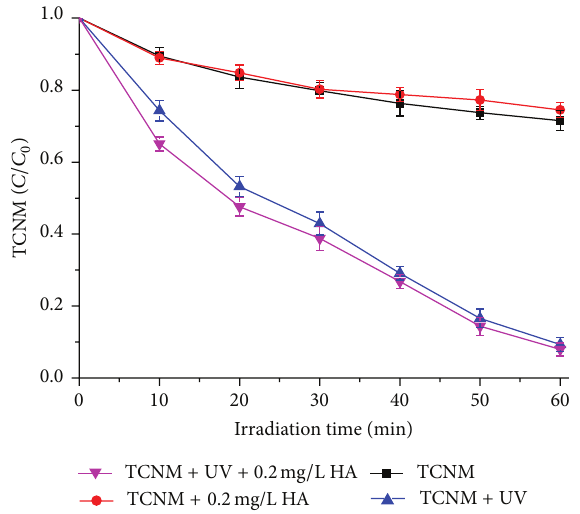
Figure 7: Effect of humic acid on the photodegradation of TCNM.